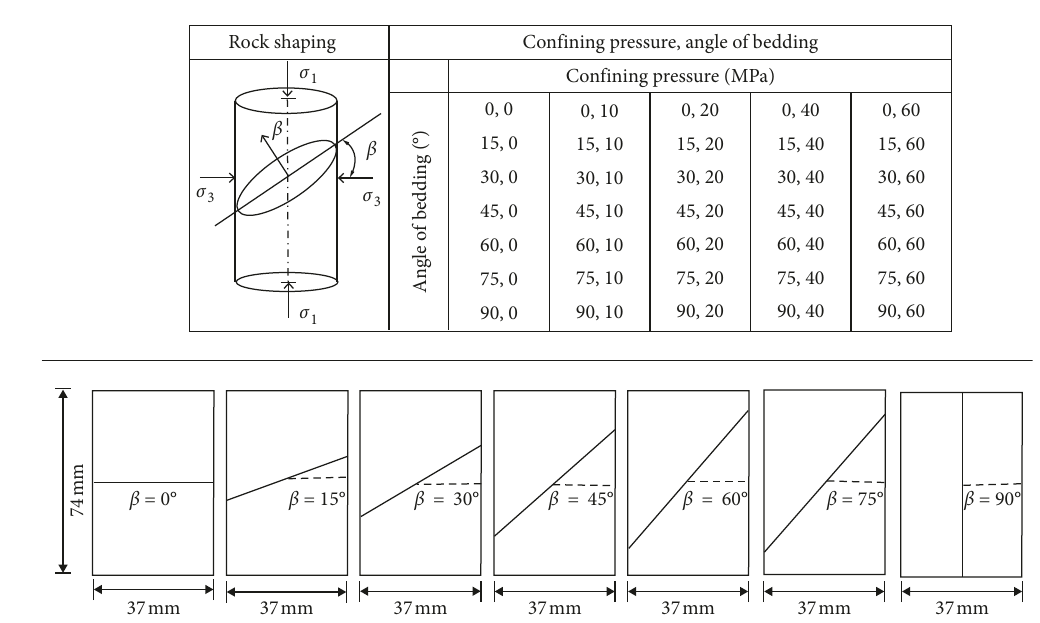
Figure 2: Diagram of confining pressure and bedding